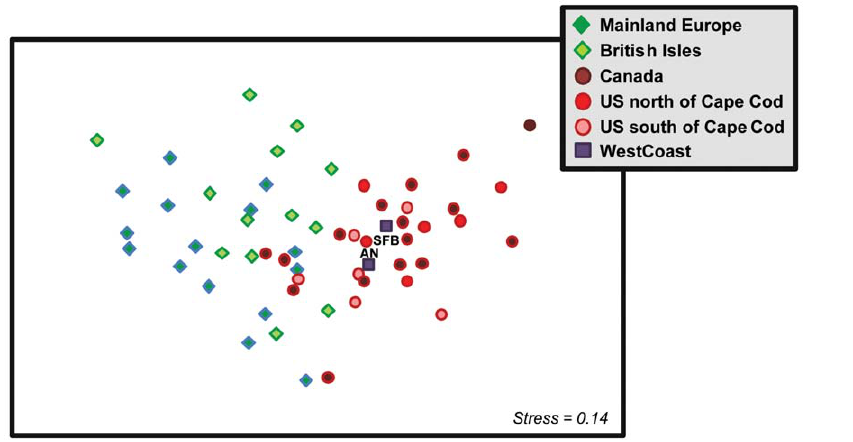
Figure 7. Multidimensional scaling plot of pairwise F ST values for Littorina littorea in European, East Coast and West Coast populations. Europe is divided into two groups, Mainland Europe (dark green diamonds) and British Isles (light green diamonds). The East Coast is divided into Canadian (dark red circles), US north of Cape Cod (medium red circles), and US south of Cape Cod (light red circles) groupings. The two West Coast populations are represented by purple squares. These data show considerable spread among Littorina littorea populations and a large degree of mixing among all groups. West Coast populations are embedded among East Coast populations.